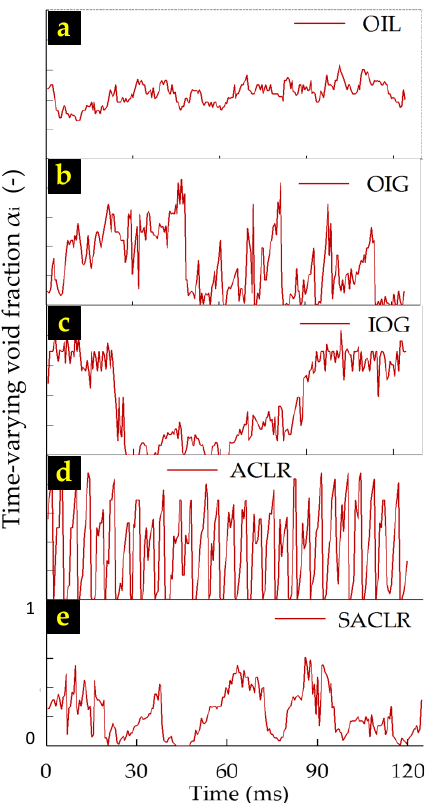
Figure 10. E ff ect of the nozzle type (i.e. ( a ) OIL; ( b ) OIG; ( c ) IOG; ( d ) ACLR; and ( e ) SACLR) on the Figure 10. Effect of the nozzle type (i.e. (a) OIL; (b) OIG; (c) IOG; (d) ACLR; and (e) SACLR) on the time-varying void fraction ( α i ) inside the exit orifice of each nozzle under the operating condition of time-varying void fraction (α i ) inside the exit orifice of each nozzle under the operating condition of GLR = 1.2%, ∆ p mix / p amb = 0.98, and µ L / µ G = 55. GLR = 1 .2%, ∆p mix /p amb = 0.98, and µ L /µ G = 55.